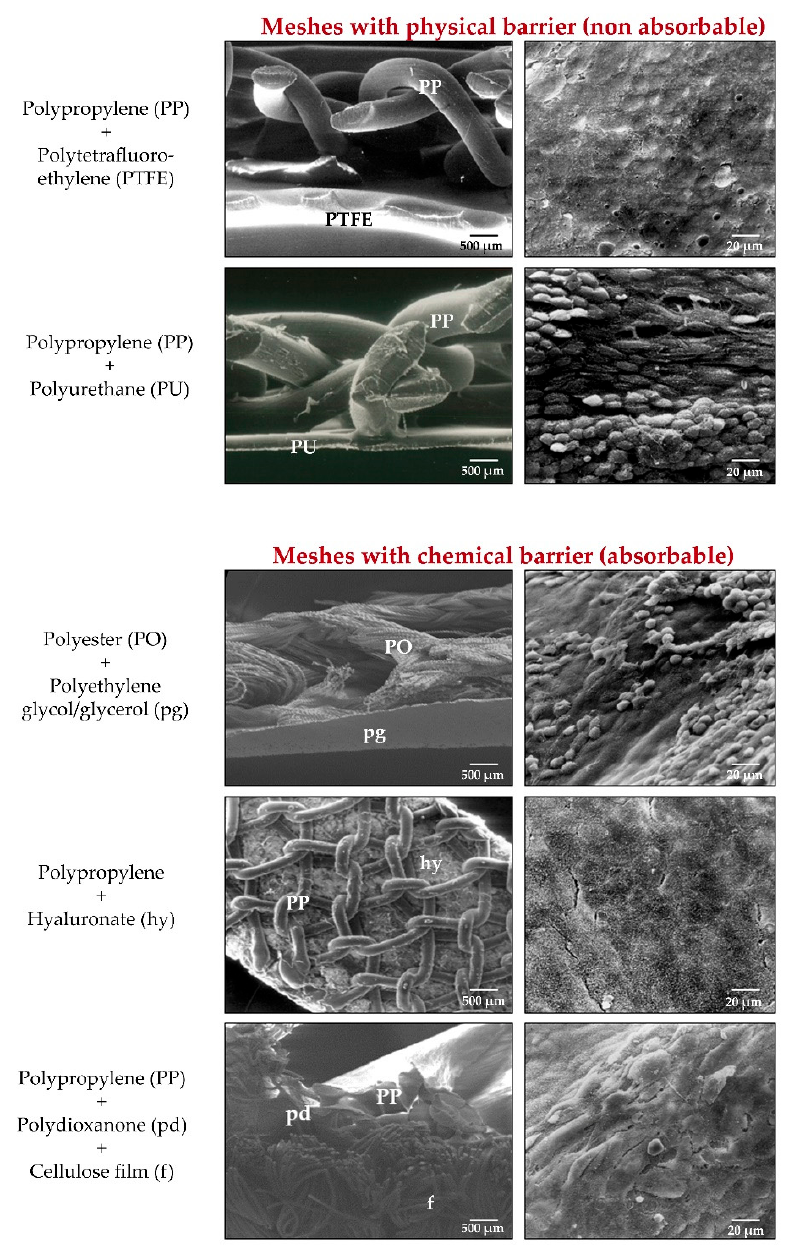
Figure 6. Scanning electron microscopy images of classic composites meshes ( left ) (lateral view, 50×. Scale bar: 500 μ m) and mesothelial layer at the peritoneal side after implant ( right , 500×. Scale bar: 20 μ m). Composites include laminar components as adhesion barriers of physical (non absorbable) or chemical (absorbable) nature.